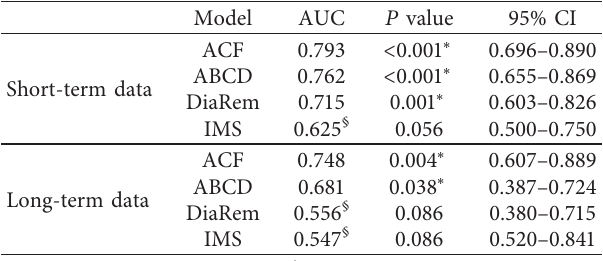
Table 9: Comparison of ROC analysis of different